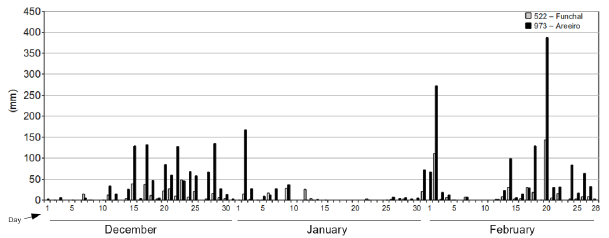
Figure 2. Daily rainfall amounts obtained for Areeiro station (black) and Funchal station 3 Fig. 2. Daily rainfall amounts obtained for Areeiro station (gray) during the winter season (DJF) 2009/2010. 4 (black) and Funchal station (gray) during the winter season (DJF)